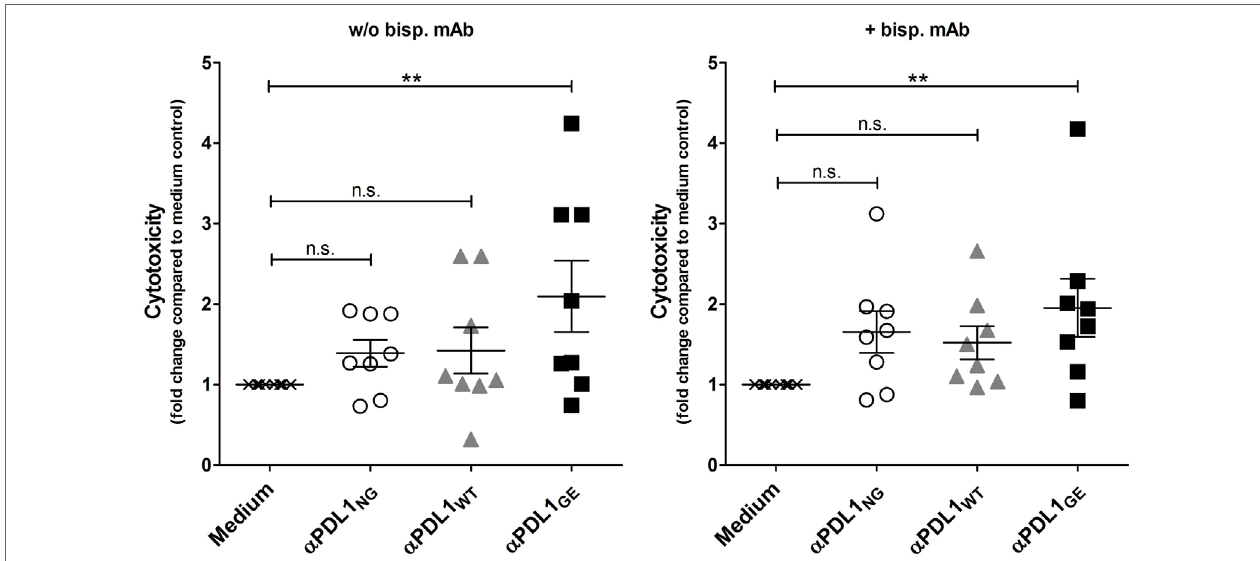
FigUre 6 | α PDL1 GE -dependent enhancement of CD8 + T cell activation results in increased cytotoxicity against cancer cells. T cells of two different donors (donor B and donor C) pre-activated in a mixed leukocyte reaction (MLR) for 5 days in the presence of α PDL1 NG (open circles), α PDL1 WT (gray triangles), and α PDL1 GE (black squares) were harvested and incubated with europium-loaded ZR-75-1 cells for 5 h to determine the lysis of target cells in an in vitro cytotoxicity assay. T cells isolated from MLR without addition of test antibody (medium; black crosses) served as negative control. The cytotoxicity assay was performed in absence and presence of a bispecific antibody binding to a tumor antigen on ZR-75-1 and to CD3 on T cells. The fold change in cytotoxicity compared to the medium control is plotted. Statistics: besides individual data points ( n = 8), mean and SEM were plotted. Significance was tested against the medium control (* p < 0.05; ** p < 0.01; *** p < 0.001; and **** p <